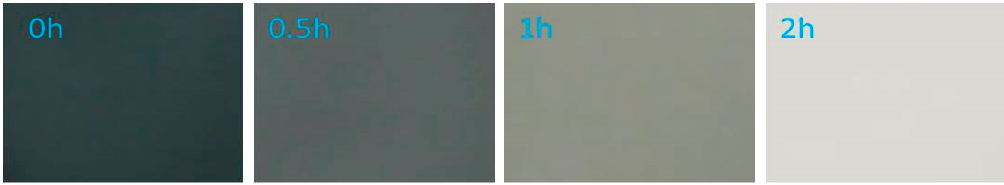
Figure 6. Residual concentration (%) and pH for System 2, as a function of the UV irradiation time exposure.